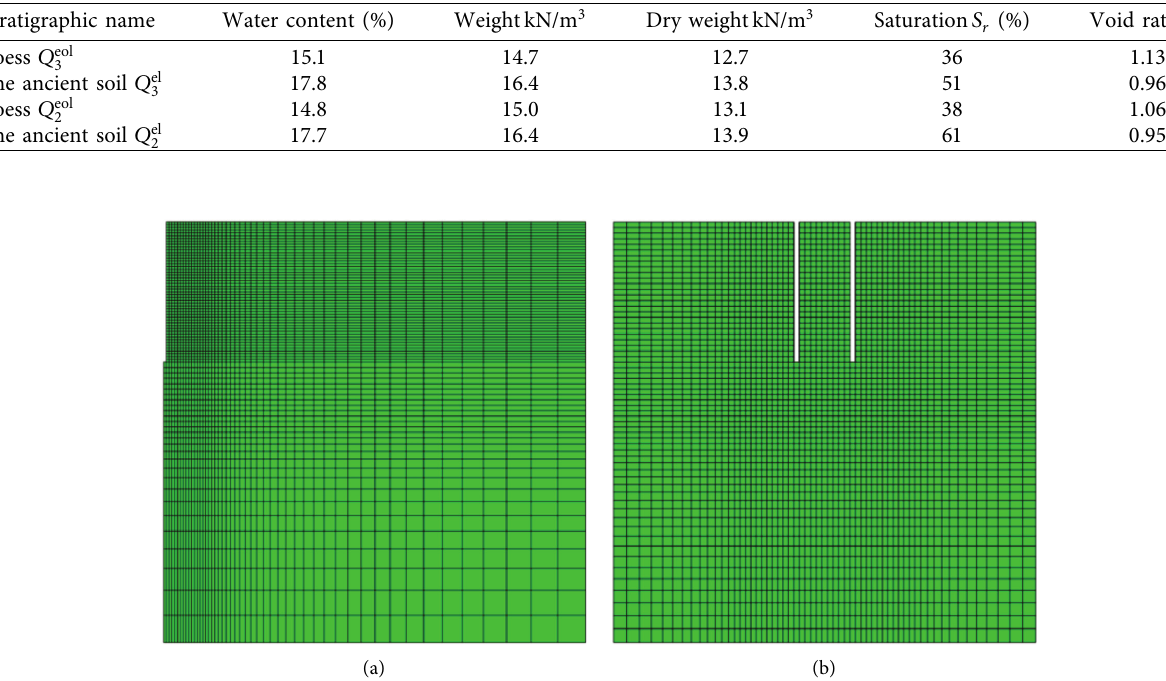
Table 2: Physical and mechanical properties of loess in the test